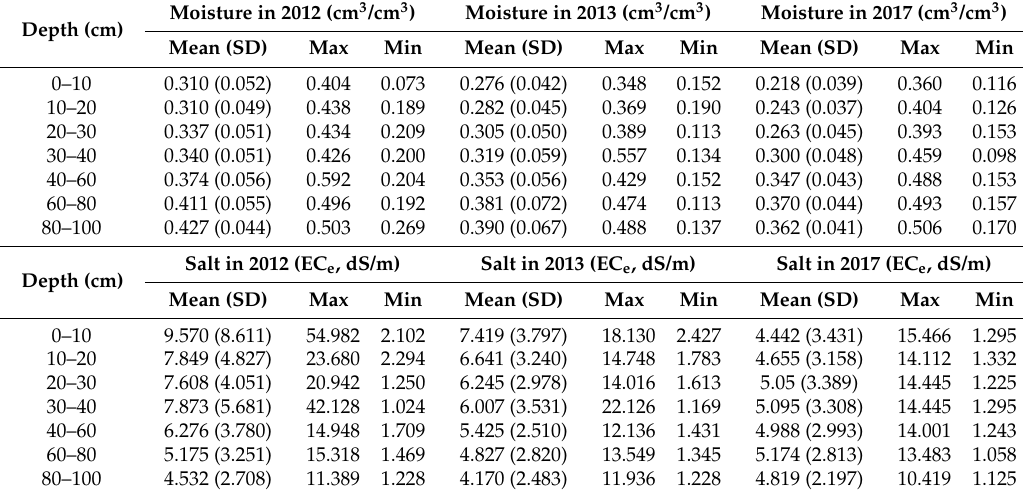
Table 4. Initial moisture and salt contents of micro-plots from 14 micro-plots and 7 fields in 2012, 2013 and